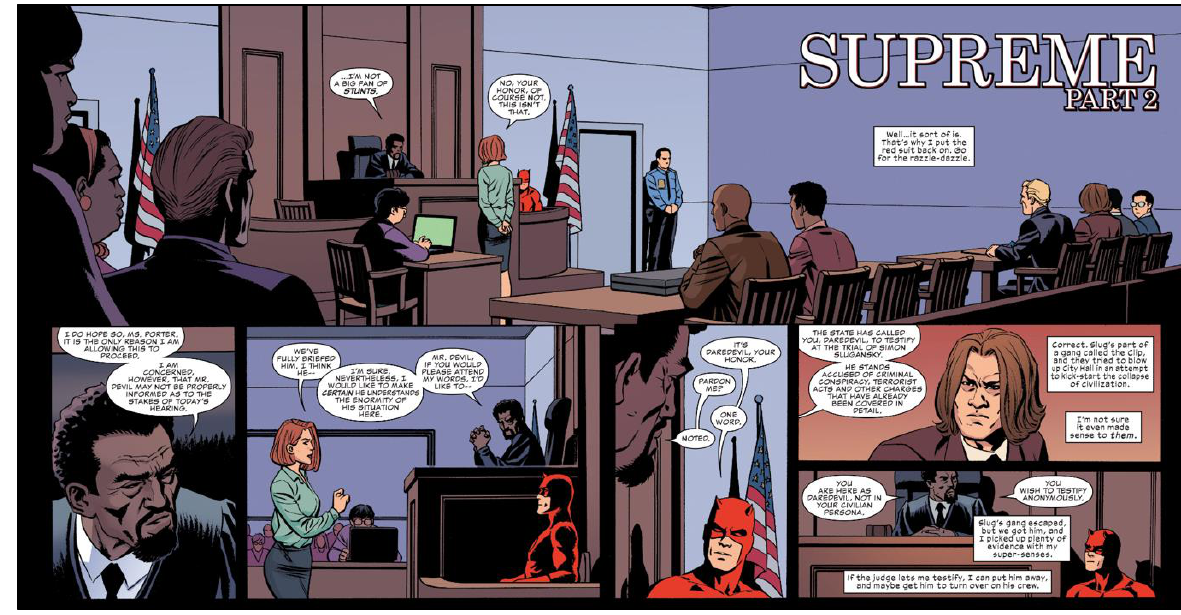
Figure 8. Page from Soule’s Daredevil: Back in Black Vol. 5: Supreme #22, 2017. Image Credit: Goran Sudžuka © 2017 Marvel Characters,